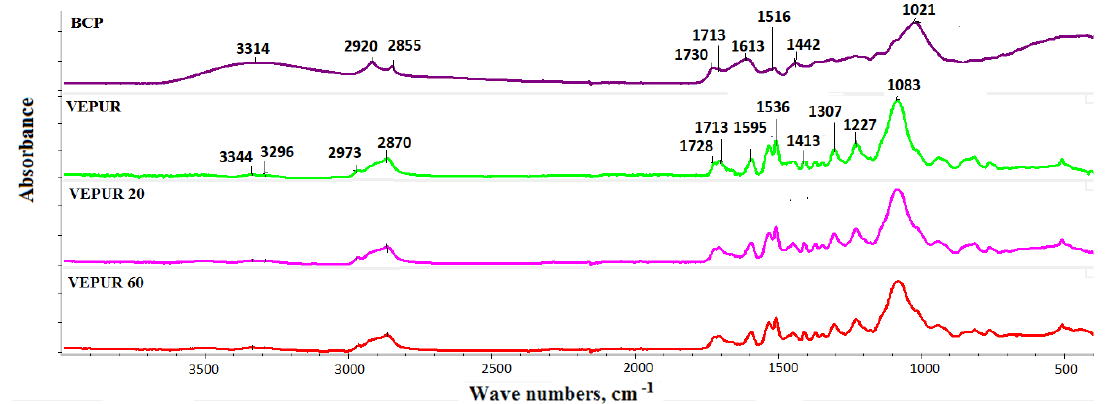
Figure 10. Fourier transform infrared (FTIR) spectrum of VEPUR and its composites.